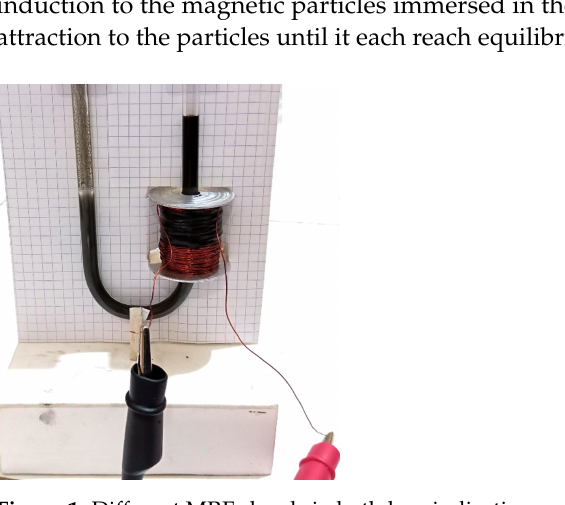
Figure 1. Different MRFs levels in both legs indicating a pressure change.